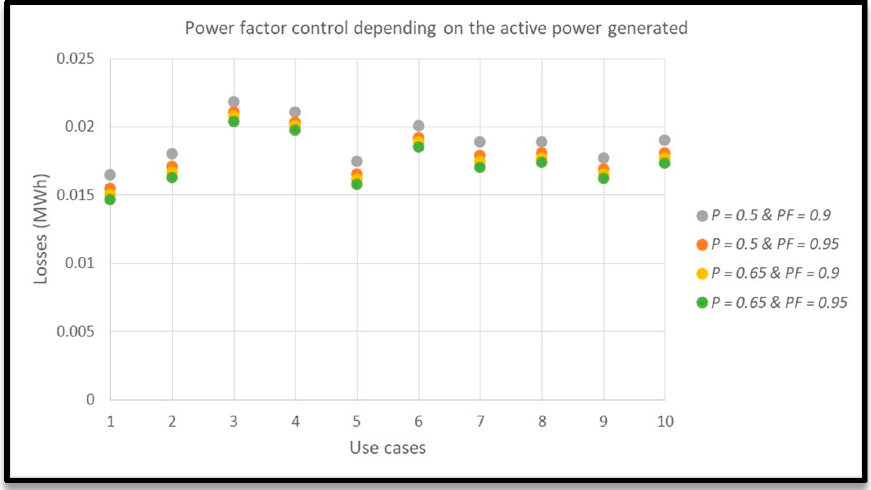
Figure 10. Reactive power control with constant power factor: Losses (More information see Table A7 in Appendix C).